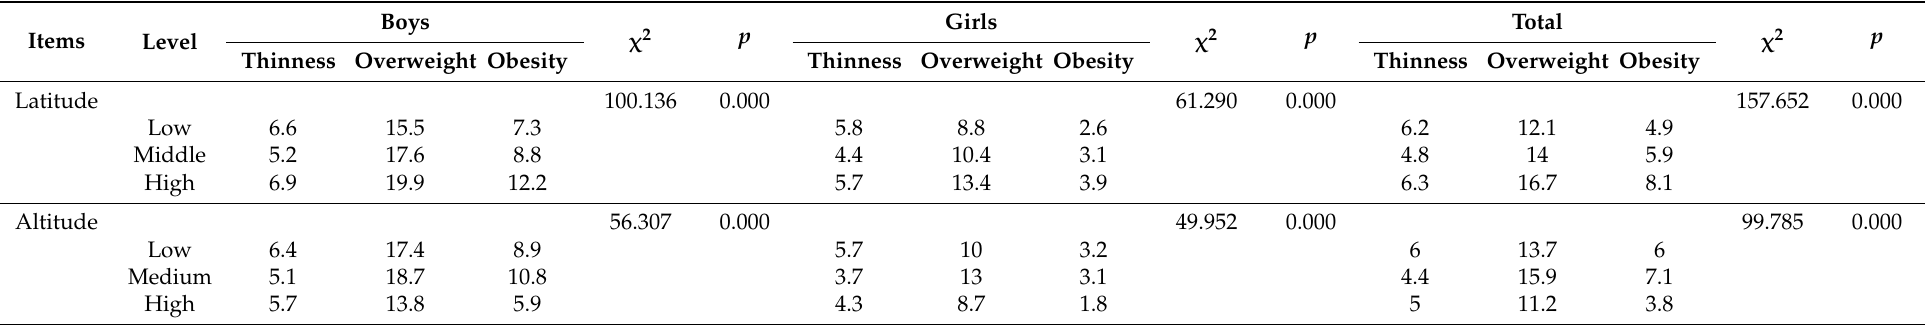
Table 4. Prevalence of overweight and obesity in children and adolescents under different natural environmental factors (%).